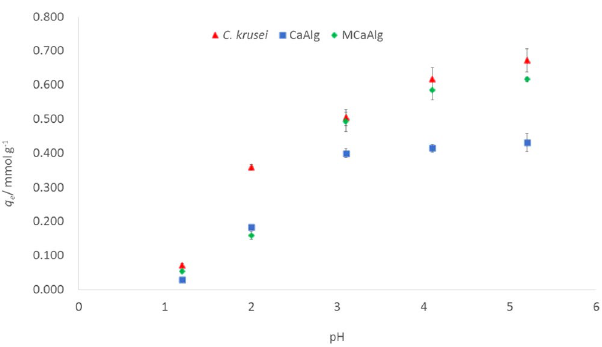
Figure 3. Effects of pH on removal of copper(II) with C . krusei , CaAlg and